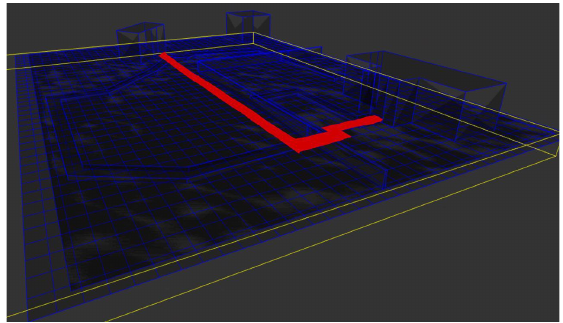
Figure 10. Indoor-to-outdoor route without taking surfaces into